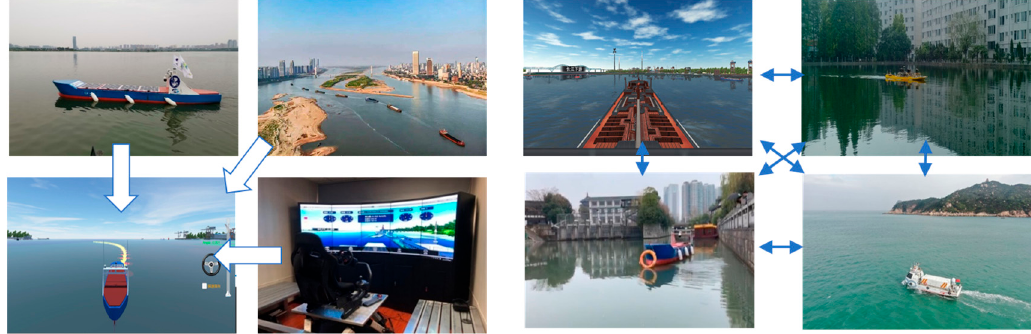
Figure 3. Ship test and verification platform with virtual simulations and physical tests.